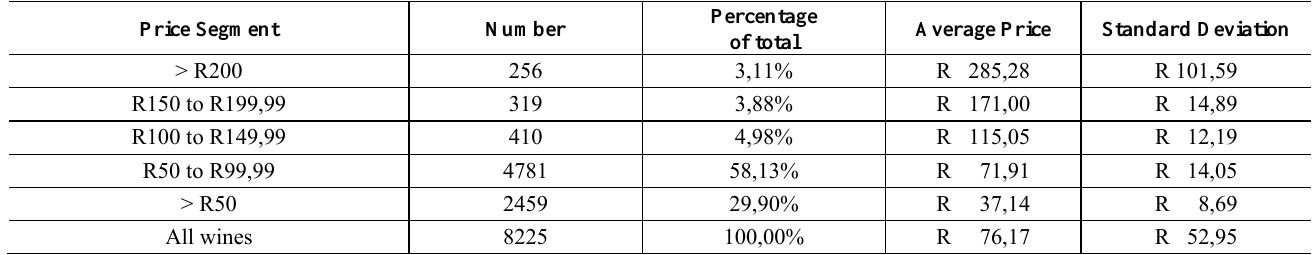
Table 6: Descriptive statistics pertaining to price (n = 8225)